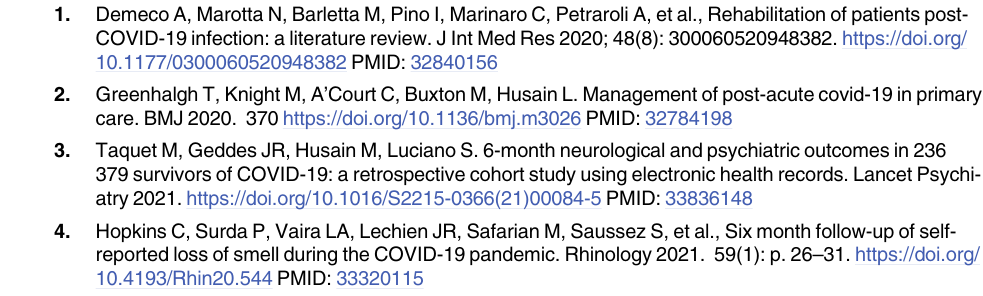
S4 Table. Difference-in-differences (DiD) estimates of impacts of COVID-19 on health care use from 12–1 weeks before PCR test for SARS-CoV-2 to 1–4, 5–8, and 9–12 weeks after as well as 13–24 weeks after PCR test. The DiD estimates captures the change in health care use from 12–1 weeks before PCR test to 1–4, 5–8, and 9–12 weeks after as well as 13–24 weeks after PCR test for men patients with severe COVID-19 compared with the change over the same period for men patients with no